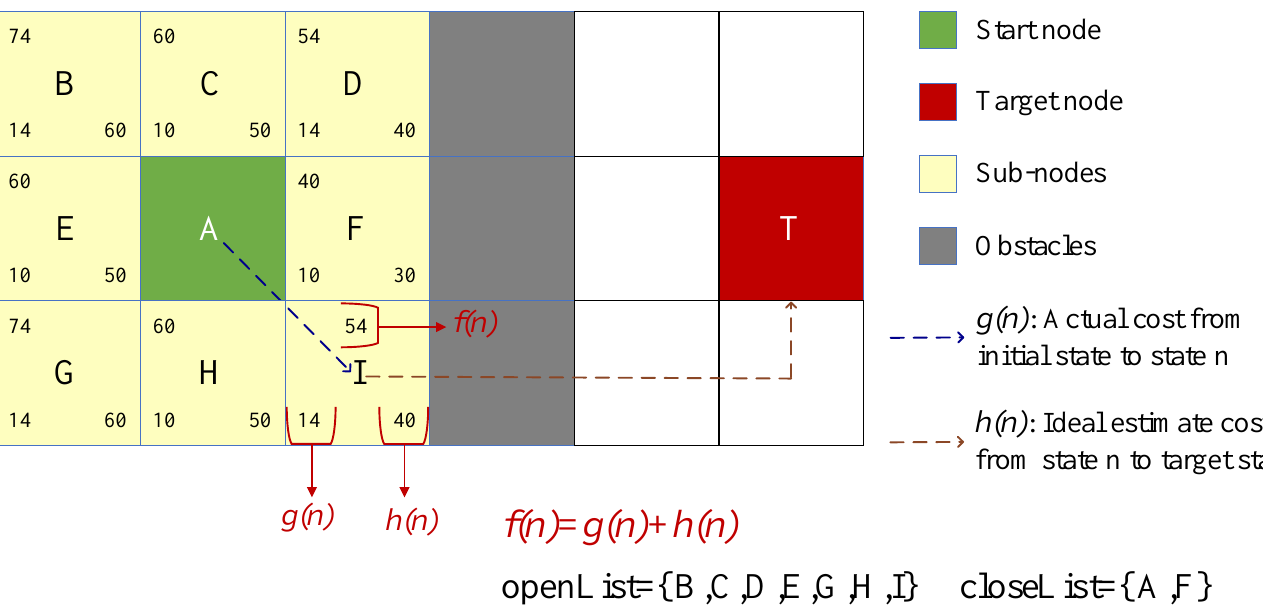
Figure 1. A* algorithm evaluation function